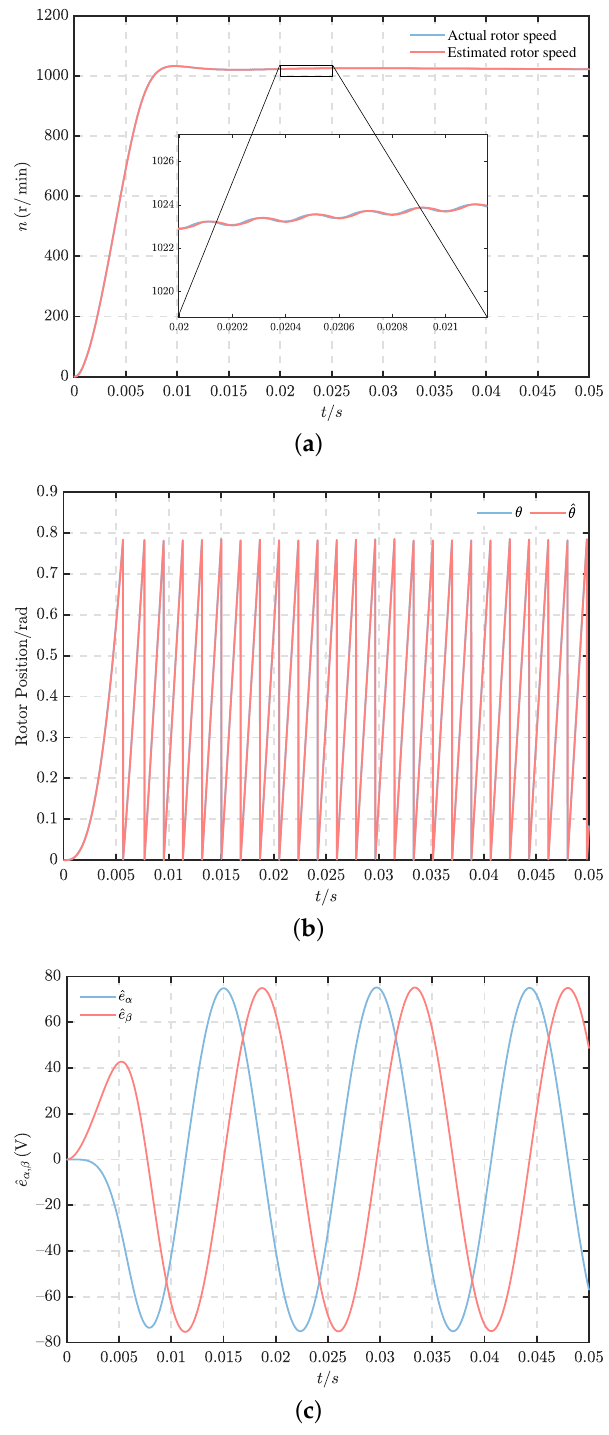
Figure 11. Responses of the simulation with improved SMO combined with feedforward PLL (steady-state). ( a ) Rotor speed. ( b ) Rotor position. ( c ) Estimation of the